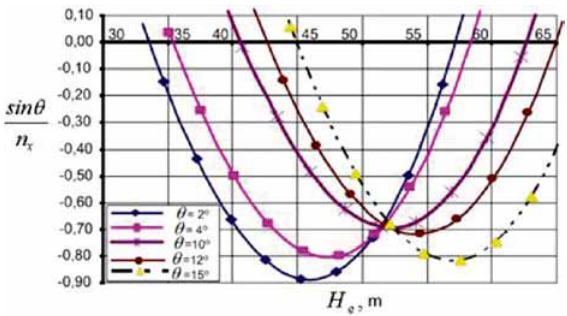
Fig. 7. Determination of the minimum height of descent under the conditions that Р = 350 N, θ 2 = 10